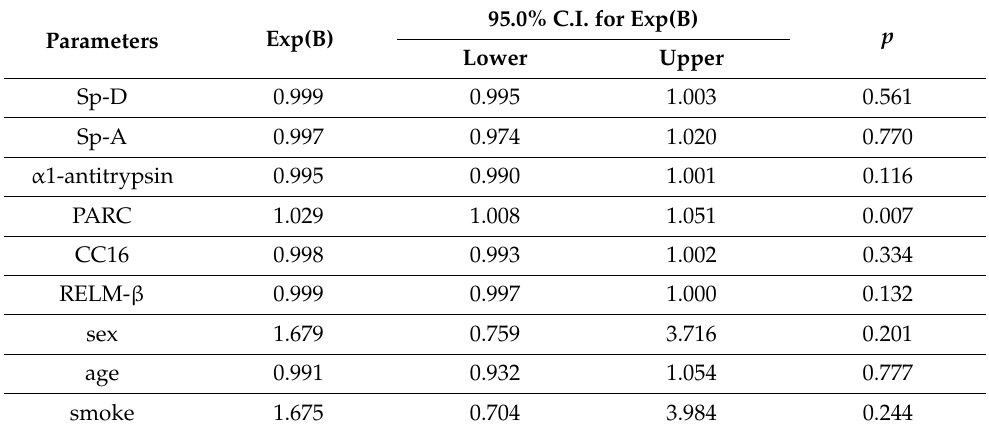
Table 4. Logistic regression analysis of the relative chance of developing a comorbid state in patients with chronic